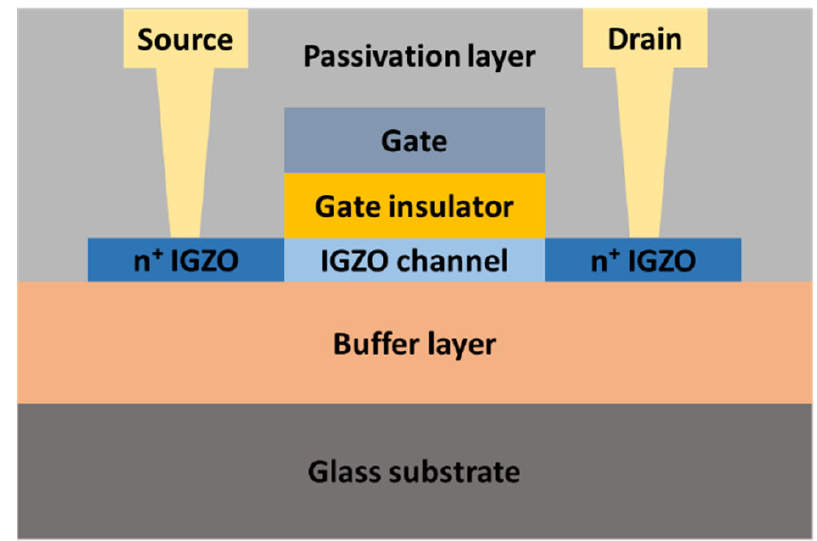
Figure 1. Structure of the fabricated SA-TG coplanar IGZO TFT.